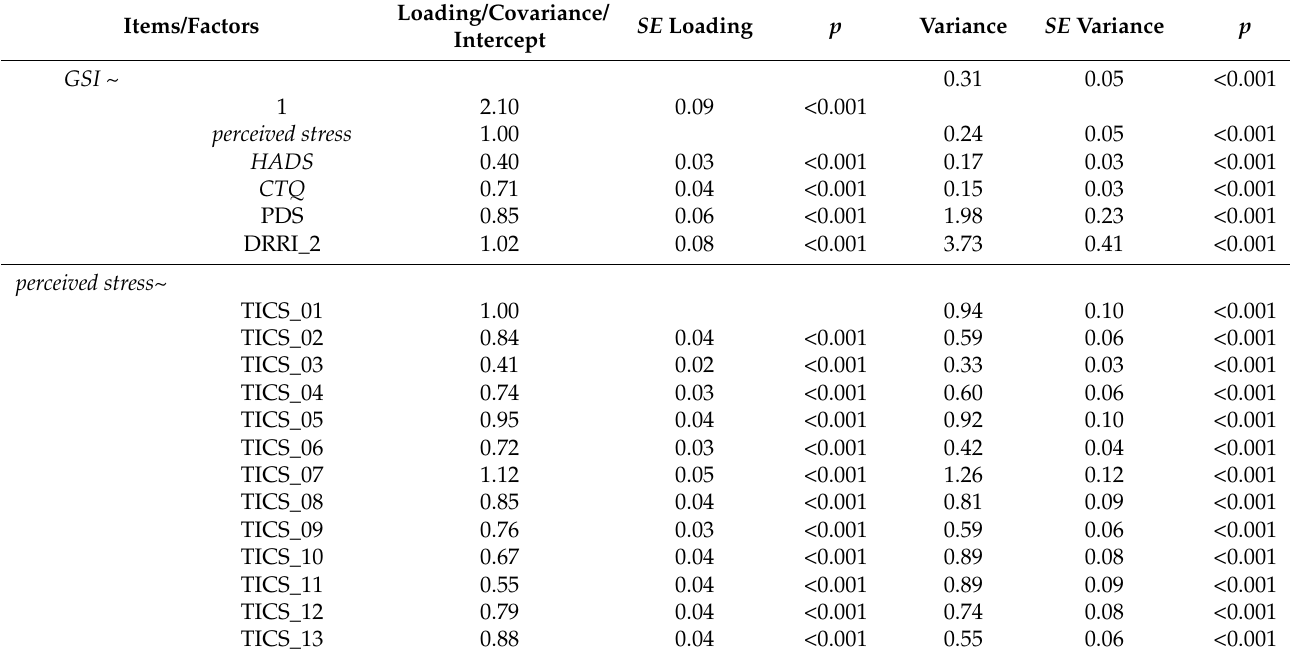
Table A2. Additional statistics and results for Model 17: loadings, variances, and